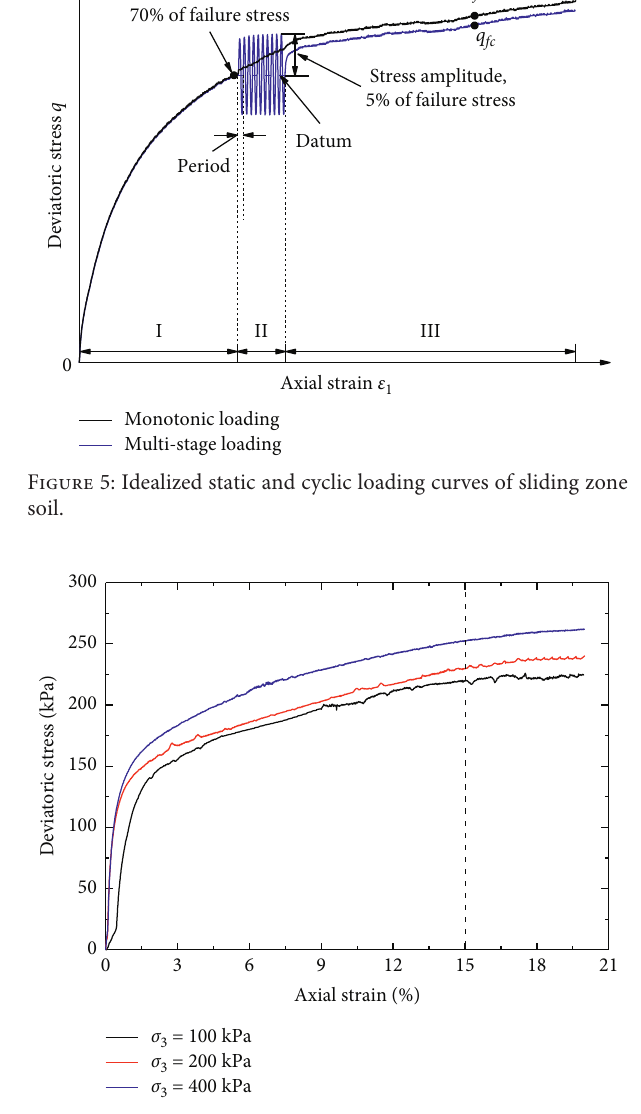
Figure 6: Stress-strain relationships of a sliding zone soil specimen under different confining